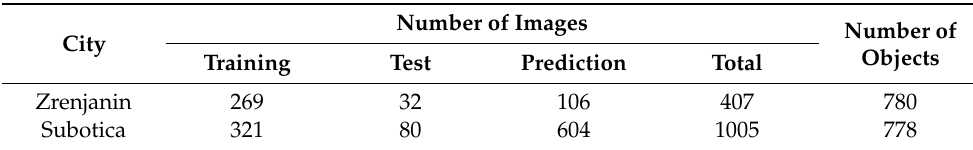
Table 1. Number of images used for training, test and prediction, and total number of objects.